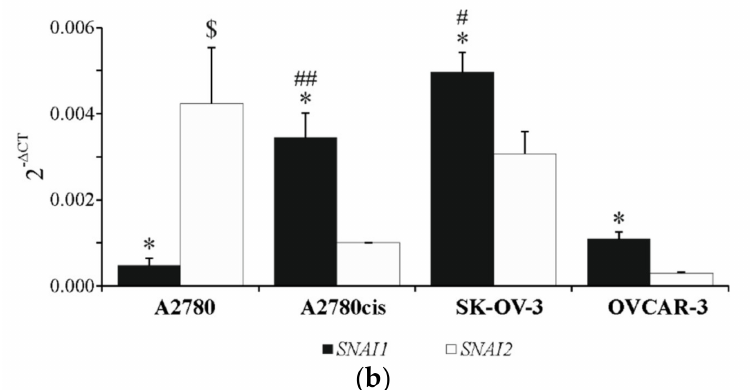
Figure 2. The expression of SNAIL 1 and SNAIL 2 in A2780, A2780cis, SK-OV-3 and OVCAR-3 cell lines. ( a ) The basal levels of SNAIL 1 and SNAIL 2 proteins were determined with immunoblotting-ECL. Representative immunoblots of SNAIL 1 and SNAIL 2, along with β -actin level, are presented. The acquired bands were quantified by densitometric analysis and data are presented as the mean optical density intensity (ODI) ± SD from four independent experiments ( n = 4). * Statistically significant difference in SNAIL 1 and SNAIL 2 level: SNAIL 1 vs. SNAIL 2 in A2780, A2780, SK-OV-3 or OVCAR-3 cell